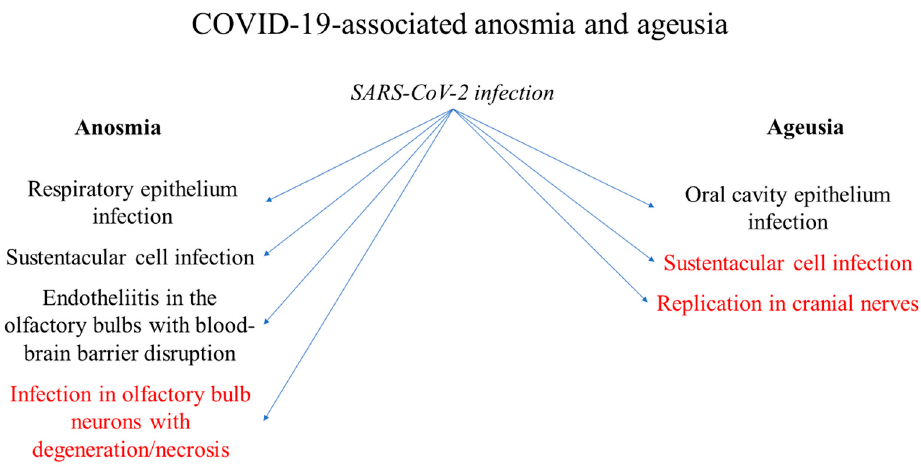
Figure 1. Mechanisms of anosmia and ageusia onset in COVID-19; red denotes disputed mecha- nisms.